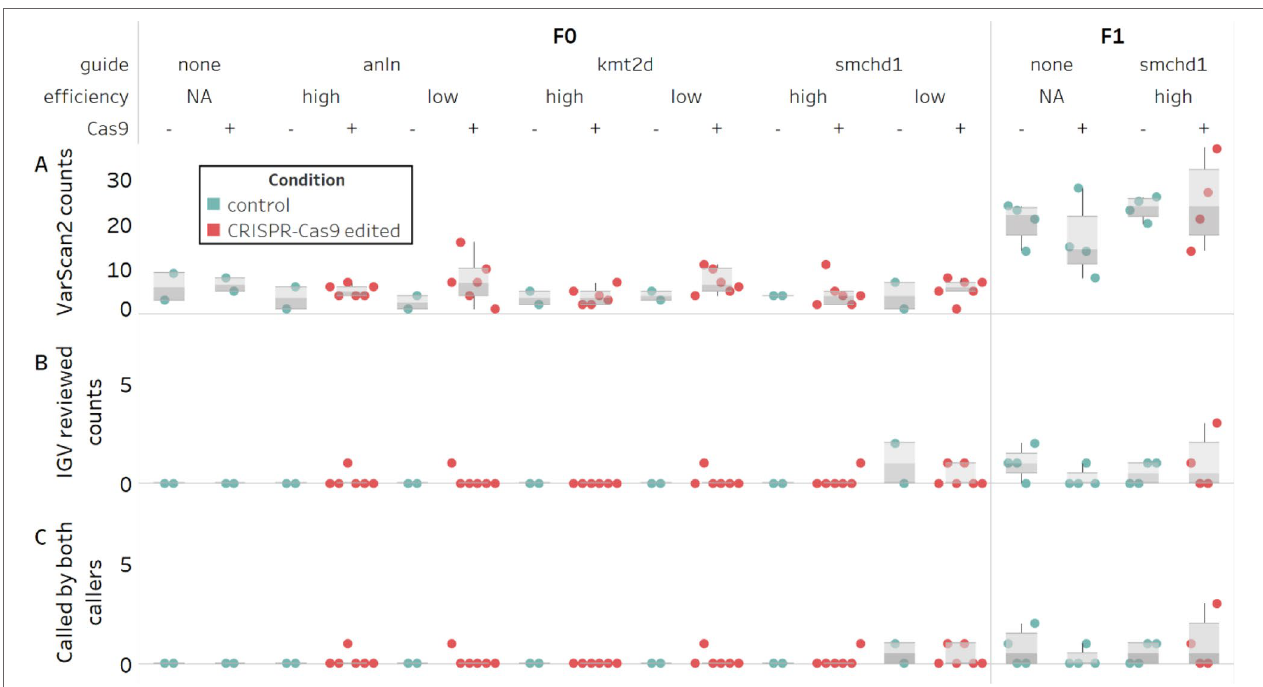
FIGURE 2 | Counts of candidate de novo mutations in control and edited individual zebrafish embryos. Variants persisting after filtering and with an allele frequency ≥0.3 are not significantly different between control and CRISPR-Cas9 edited groups (N = 68). (A) Predicted counts by VarScan2. (B) Unambiguous heterozygous variants determined by visual inspection of VarScan2 calls in IGV (C) Subset of predicted variants detected by both variant